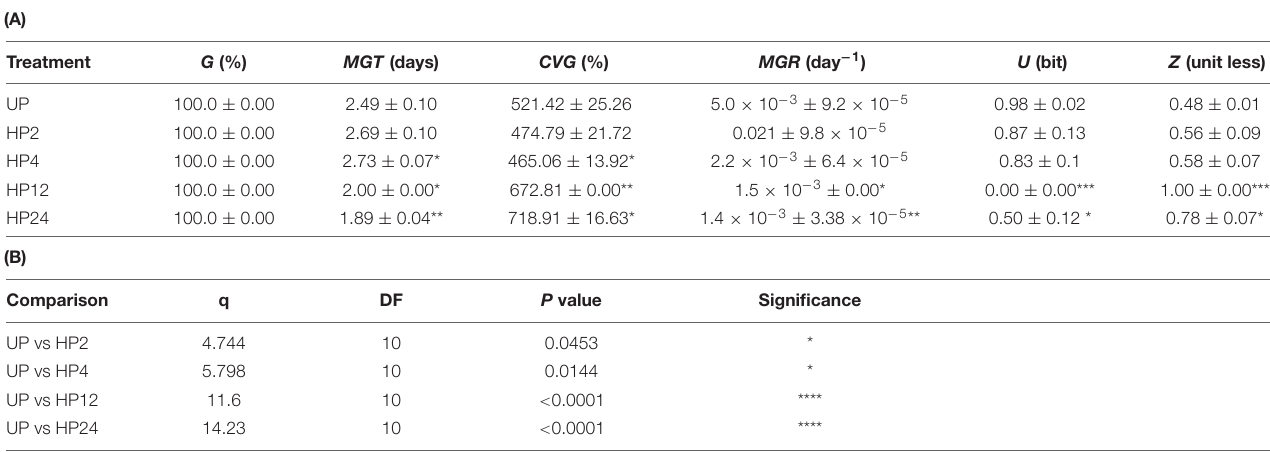
TABLE 2 | (A) Germination parameters calculated based on results of germination tests carried out on S. villosum seeds (seed lot collected in 2018) treated with hydropriming (HP) for increasing time (2 h, 4 h, 12 h, and 24 h) and unprimed (UP) seeds. (B) Results of Two-way ANOVA analysis comparing germination parameters of the unprimed (UP) S. villosum seeds versus primed seeds (HP2, HP4, HP12, and HP24 treatments) carried out using the post hoc Tukey’s HSD test ( P ≤ 0.05). Values are expressed as means ± SD from three independent replicates. Asterisks indicate statistically significant differences between primed and unprimed seeds determined using Student’s t test ( P < 0.05). G , Germinability. MGT , Mean germination time. CVG , Coefficient of velocity of germination. MGR , Mean germination rate. U , Uncertainty. Z , Synchronization index. * P < 0.05, ** P < 0.01, *** P < 0.001, and **** P <